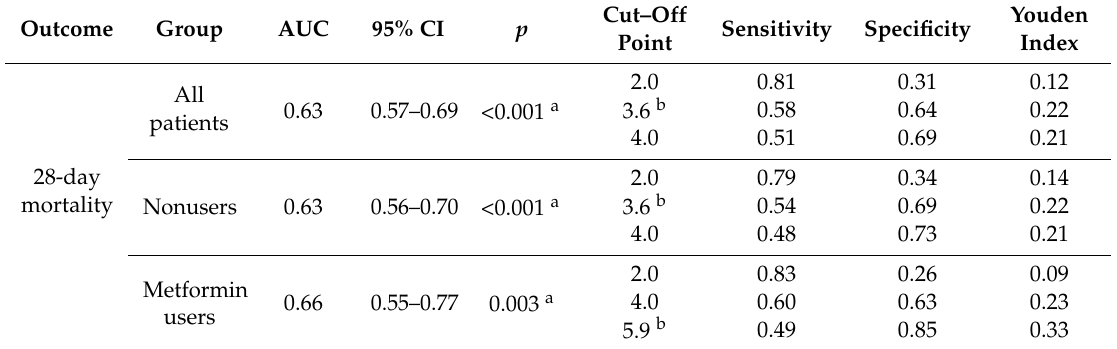
Figure 3. Receiver operating characteristic curve analysis of serum lactate levels for predicting 28-day mortality: ( a ) all patients, ( b ) nonusers, and ( c ) metformin users. Table 3. Receiver operating characteristic analysis of serum lactate levels to predict 28-day mortality.